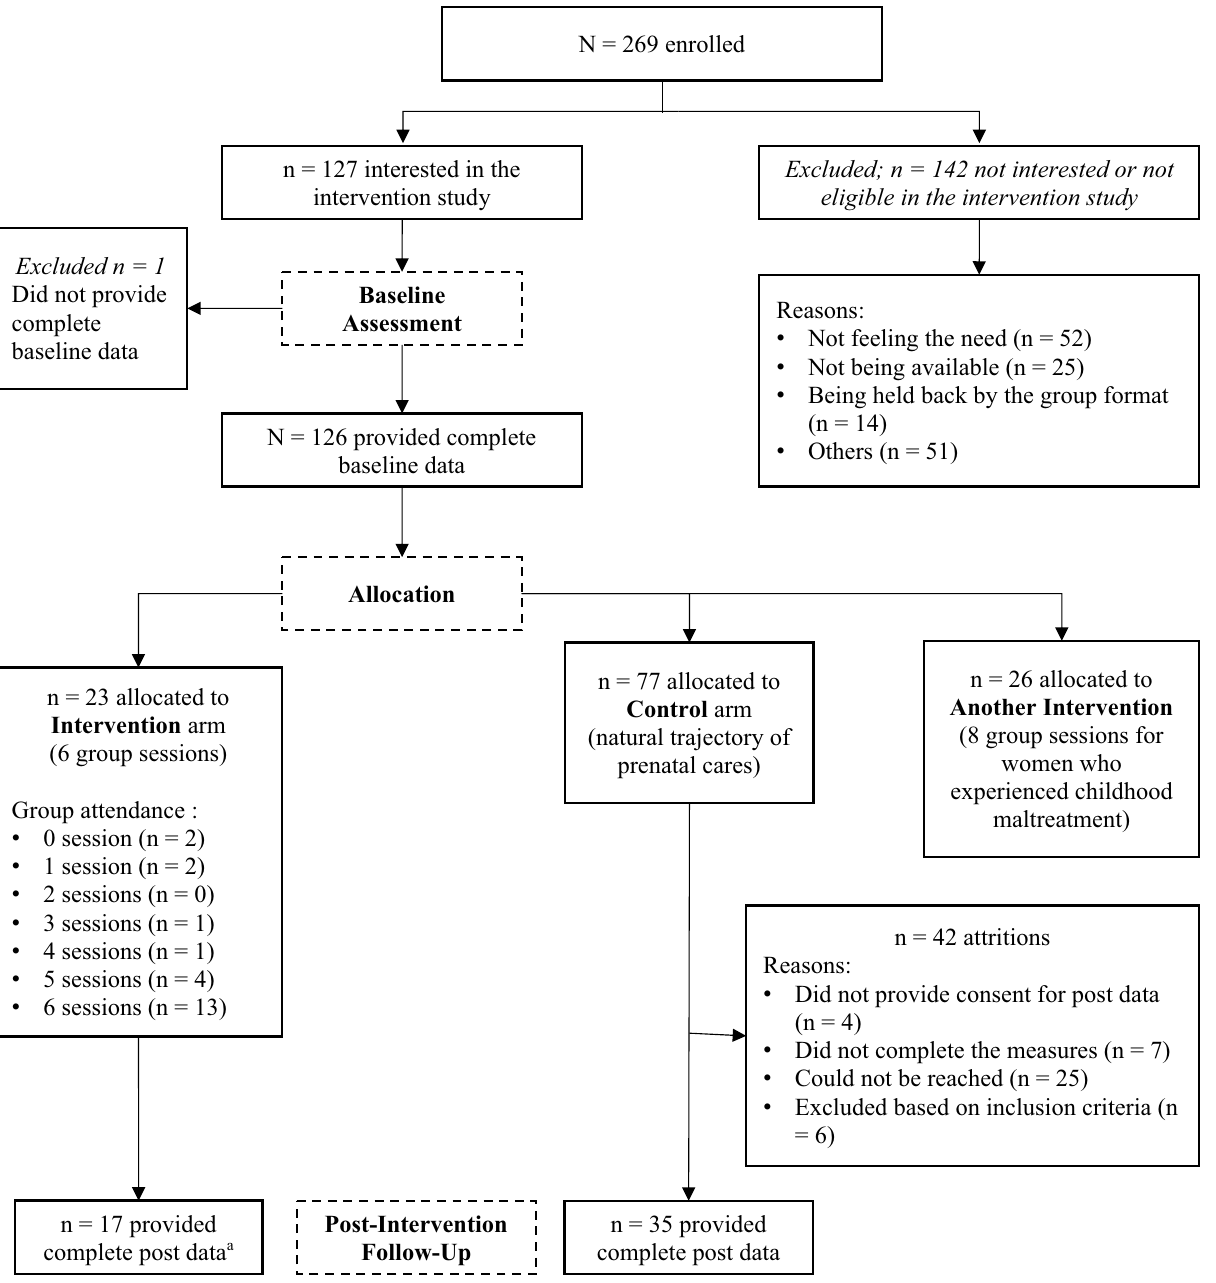
Figure 1. Study Flow Chart. a The four participants who left the intervention before or after the first meeting had scheduling conflicts. One participant left after three sessions due to a lack of commitment in the intervention frame (e.g. not opening the camera; arriving